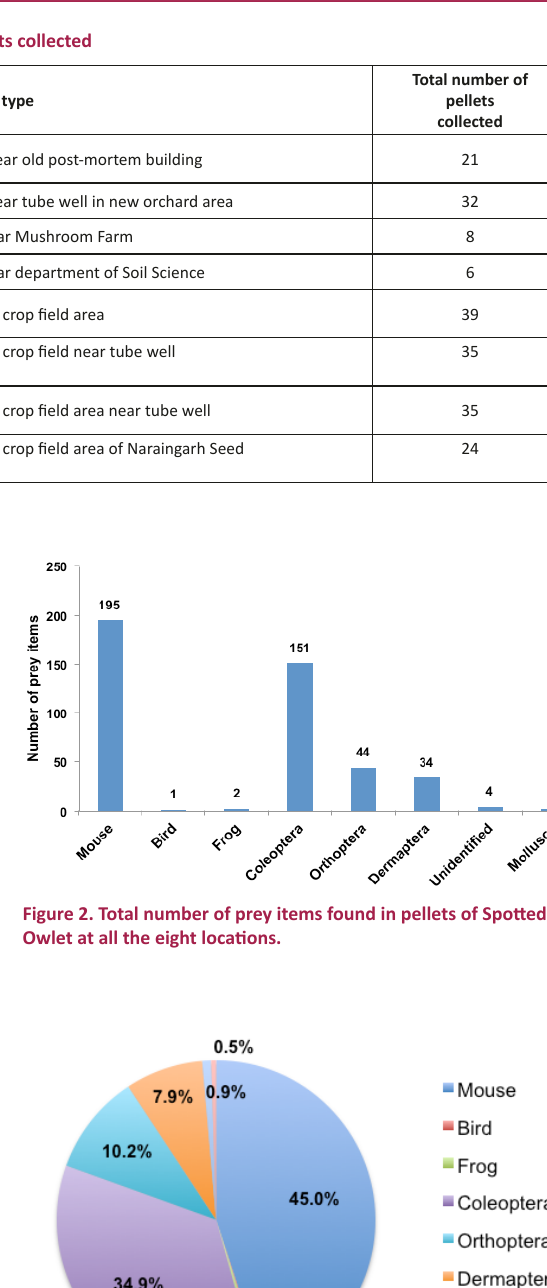
Fig. 4. Different bones of mice found were that of skull, lower jaws, ear capsules and other dislocated bones of skull, breast bones, ribs, shoulder bones, bones of fore limbs, hip bones, bones of hind limbs, hand/foot bones, patella, vertebrae and some unidentified bones. The